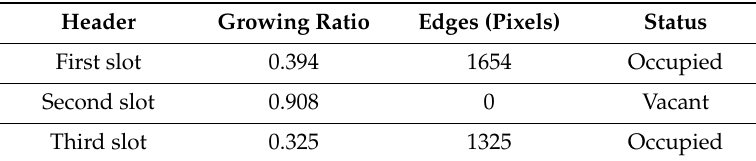
Table 2. Parking space features at Guang Hua Digital Plaza.